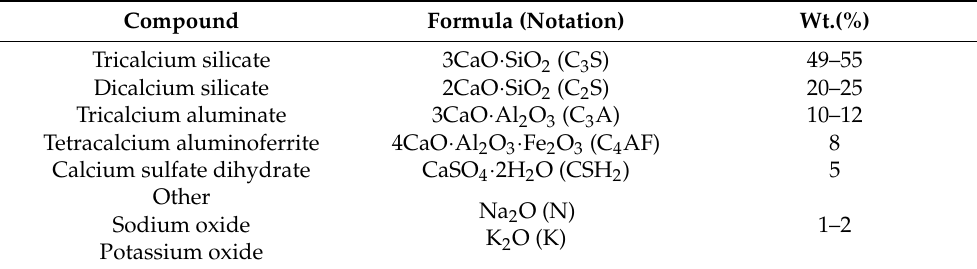
Table 2. Chemical composition of the OPC clinker [29,30]. Compound Formula